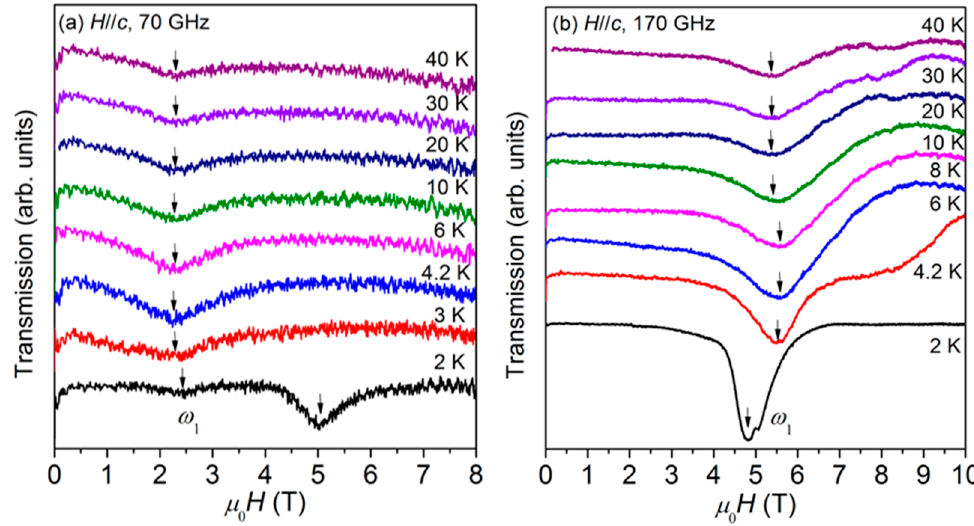
Figure 6. Temperature-dependent ESR spectra measured at 70 GHz ( a ) and 170 GHz ( b ) along the hard c axis.